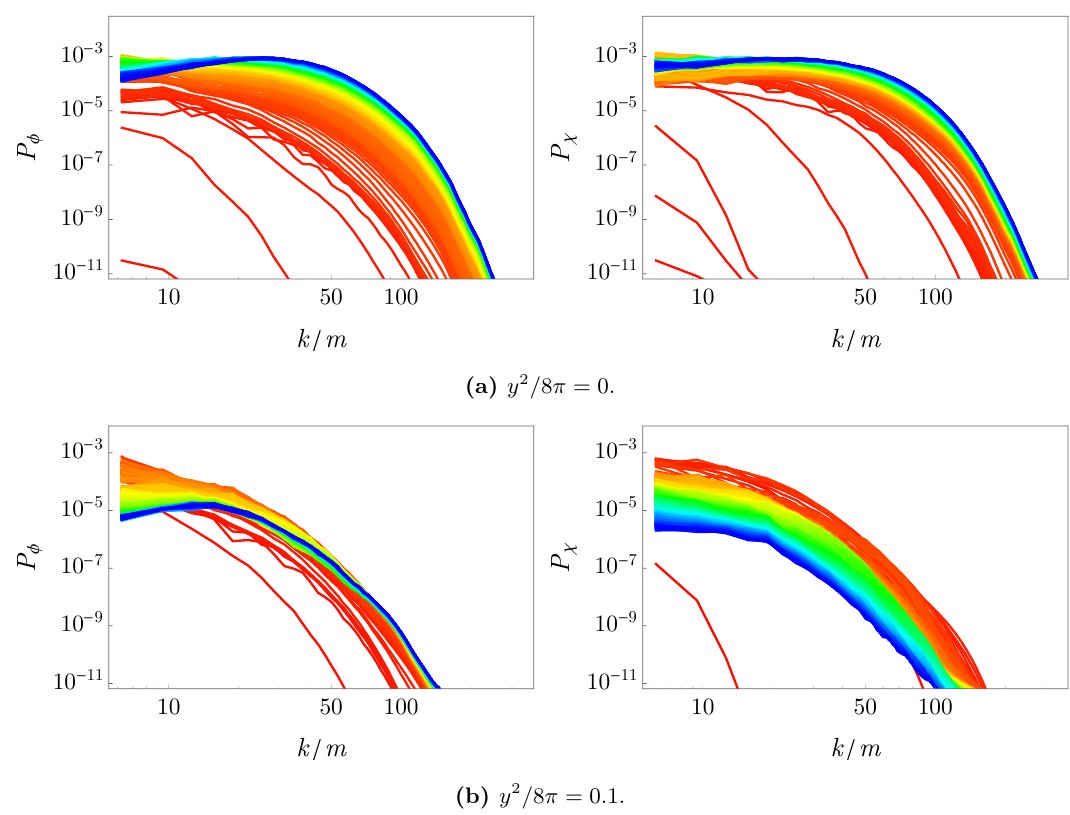
Figure 6. The time evolution of field power spectra for b = 0 . 9 , m = 10 − 6 M pl , Φ 0 = f = M pl , q 0 = 200 , and y 2 / 8 π = 0 or 0.1. For each field F , P F is the comoving power P F ≡ (d / d ln k ) a 3 F ( x ) 2 in units of M . Time evolves from red to blue. For y 2 / (8 π ) = 0 . 1 , there is little propagation of pl power to the UV compared to the y = 0